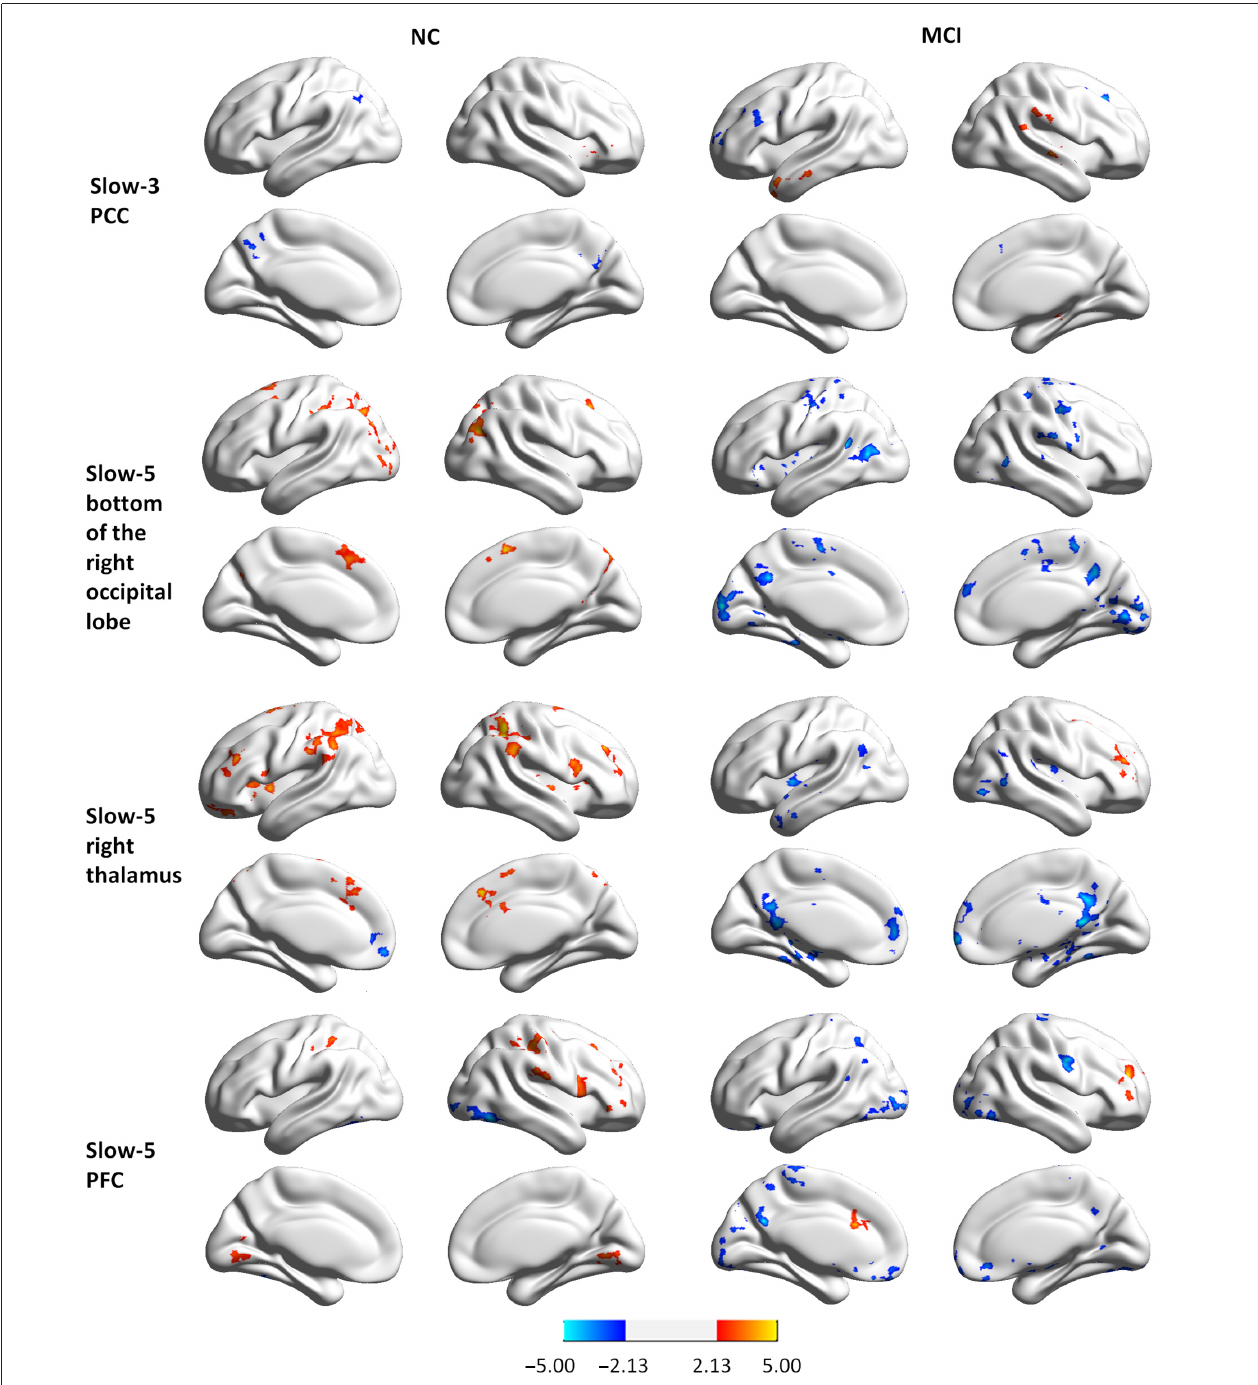
FIGURE 4 | Group differences in seed-based connectivity maps in resting and task states for four clusters showing group × state interactions: the PCC in slow-3, and the bottom of the right occipital lobe, the right thalamus, and the PFC in slow-5.